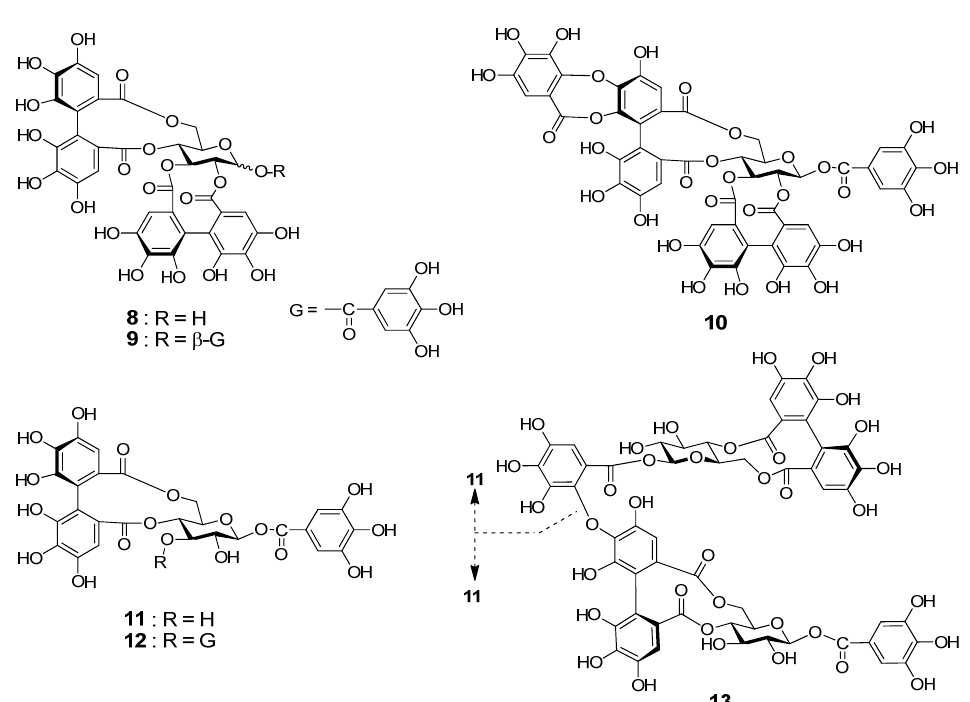
Figure 3. Structures of platycaryanin E ( 13 ) and known compounds pedunculagin ( 8 ), casuarictin ( 9 ), alnusnin A ( 10 ), strictinin ( 11 ), and 1,3-di- O -galloyl-4,6-( S )-HHDP- β - D -glucose ( 12 ). Platycaryanin E ( 13 ) is a dimer of strictinin ( 11 ).